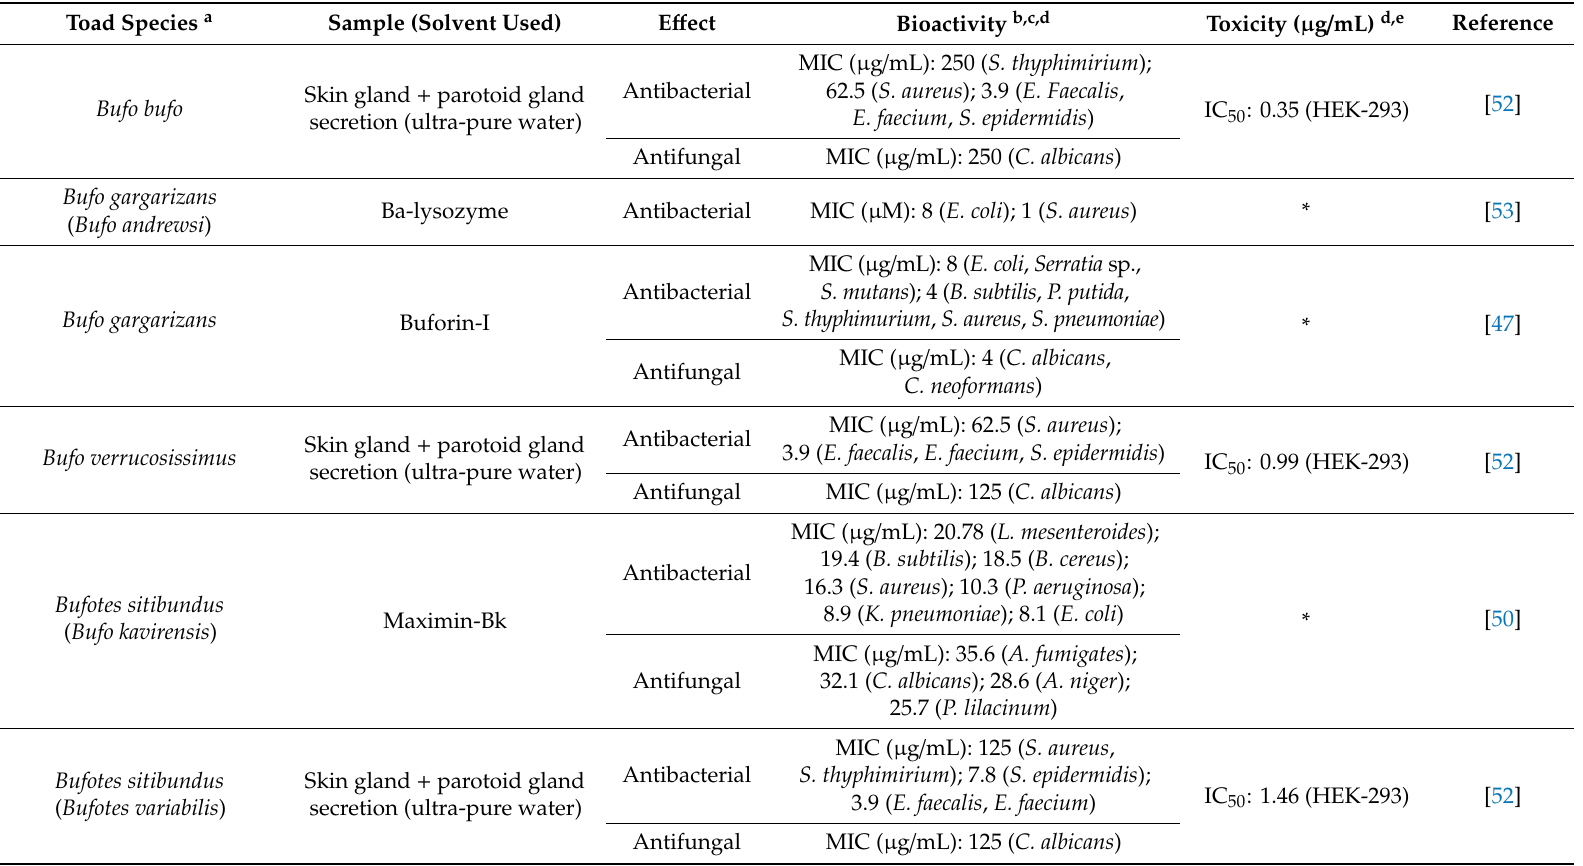
Table 1. Antimicrobial activity from true toads against human pathogenic bacteria, fungi, and